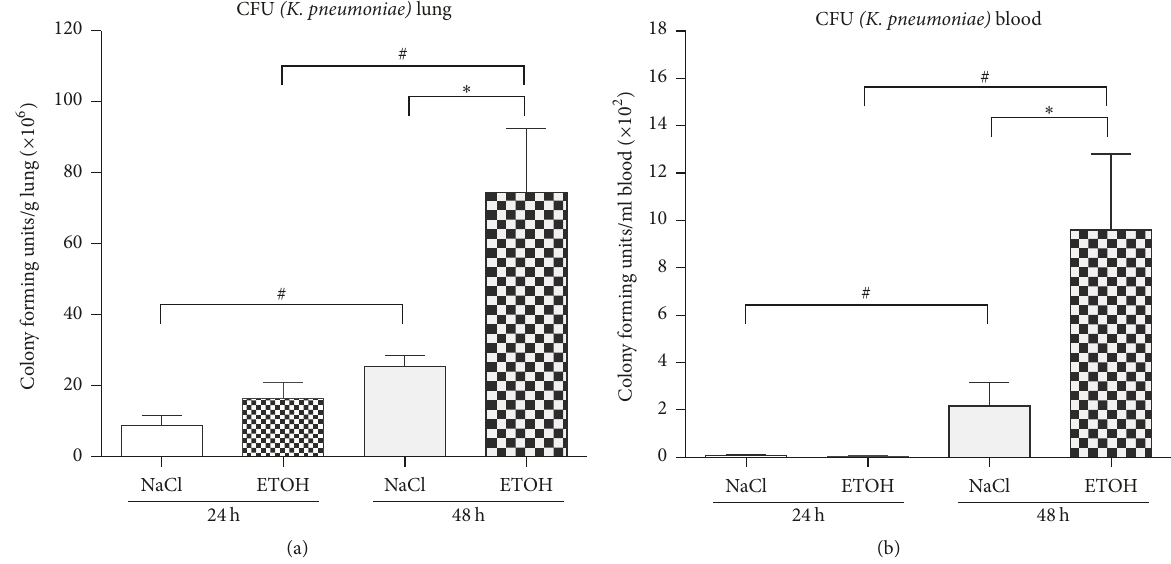
Figure 3: Analysis of colony forming units (CFUs) of Klebsiella pneumoniae in a murine model of ethanol exposition for 2 weeks, surgery, and pulmonary infection. (a) Colony forming units (CFU x/g lung tissue × 10 6 ) in the lung of animals in ethanol-treated (ETOH) and saline- treated controls (NaCl) at 24 hours or 48 hours after pulmonary infection. # 𝑝 < 0.05 when comparing 24 hours to 48 hours (time-dependent effects); ∗ 𝑝 < 0.05 when comparing ethanol treatment and saline-controls at the same time-point (ethanol-dependent effects); data are presented as mean ± SEM, Mann–Whitney U test ( 𝑛 = 8 each group). (b) Colony forming units (CFU x/ml blood × 10 2 ) in the blood of animals in ethanol-treated (ETOH) and saline-treated controls (NaCl) at 24 hours or 48 hours after pulmonary infection. # 𝑝 < 0.05 when comparing 24 hours to 48 hours (time-dependent effects); ∗ 𝑝 < 0.05 when comparing ethanol treatment and saline-controls at same